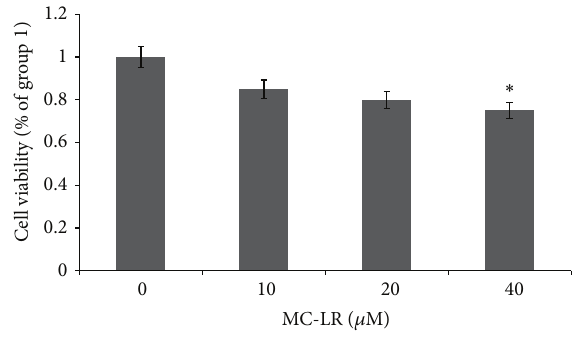
Figure 1: The MC-LR inhibited proliferation in HUVECs. Data are expressed as the mean values ± standard deviation of at least three independent experiments. Representative microphotographs are shown. ∗ 𝑝 < 0.05 versus control ( 𝑛 = 3 independent experiments).